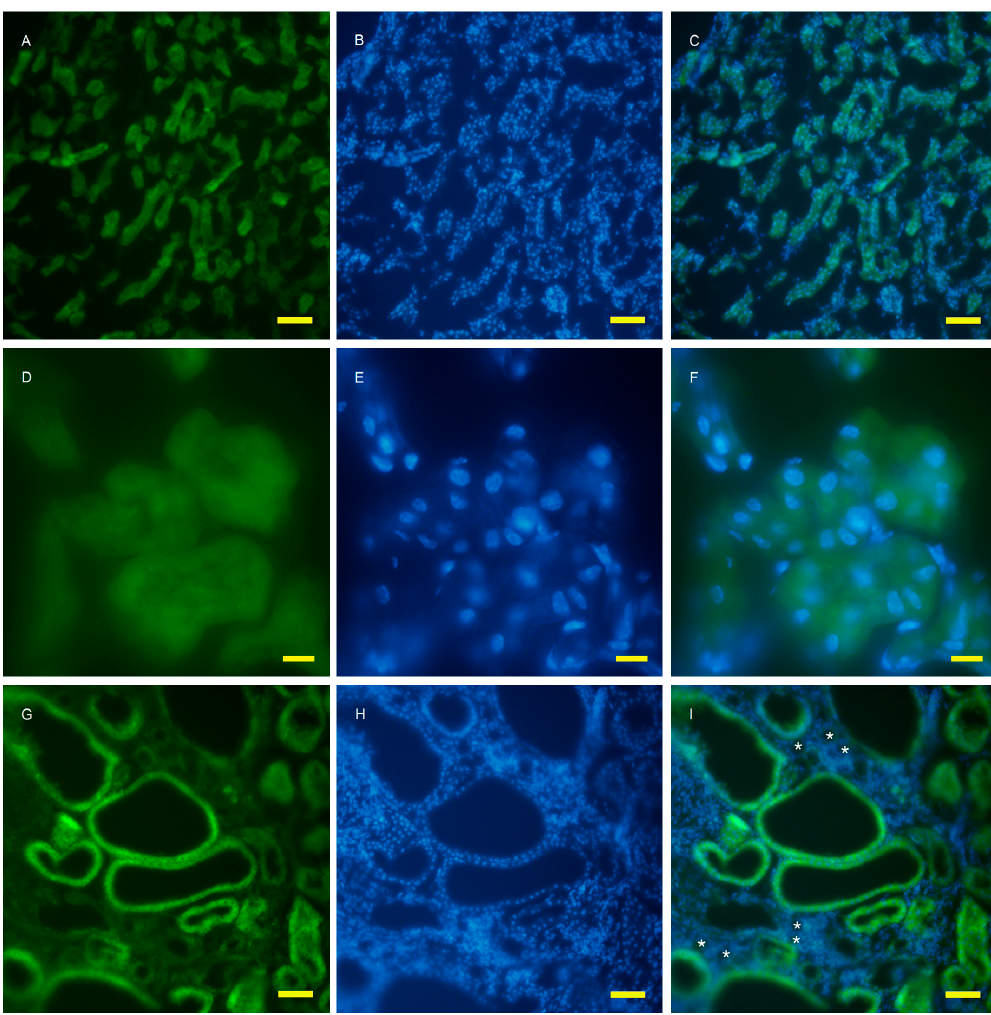
Figure 3. Fluorescent microscopy of the 2 week old kidney cortex of GFP-LC3 transgenic mice that were crossed with AQP11 knockout or wild-type mice. Green fluorescence shows GFP-LC3 ( A , D , G , J ), while blue fluorescence indicates nucleic staining with DAPI ( B , E , H , K ). Both images are merged ( C , F , I , L ); ( A – F ) are from wild-type mice and ( G – L ) are from AQP11( − / − ) mice; ( A – C ) and ( G – H ) are at the lower magnification, while ( D – F ) and ( J – L ) are at the higher magnification, with bars indicating 50 and 10 µ m length, respectively. The asterisks indicate the distal tubule ( I ). Similar observations were made in three separate sets of experiments.